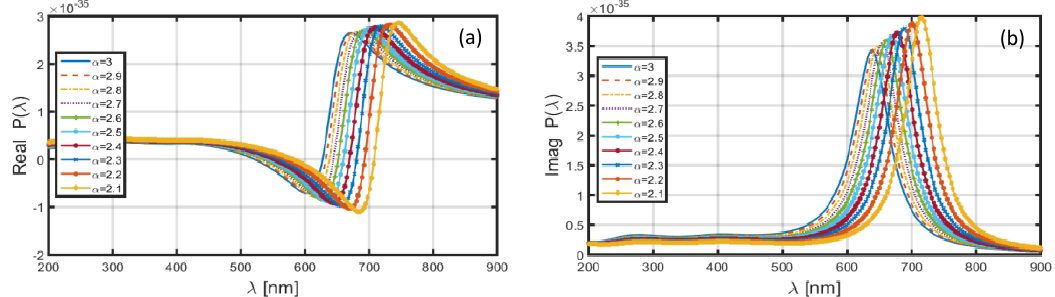
Figure 4. Wavelength-dependence of the ( a ) real and ( b ) imaginary parts of polarizability of the nanoparticle coated with Au.